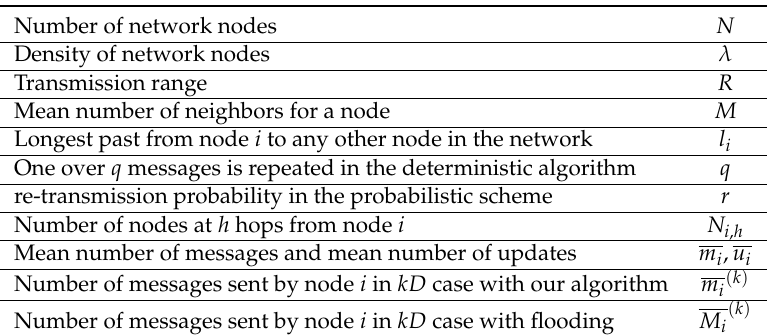
Table 1. Notations used in analytical